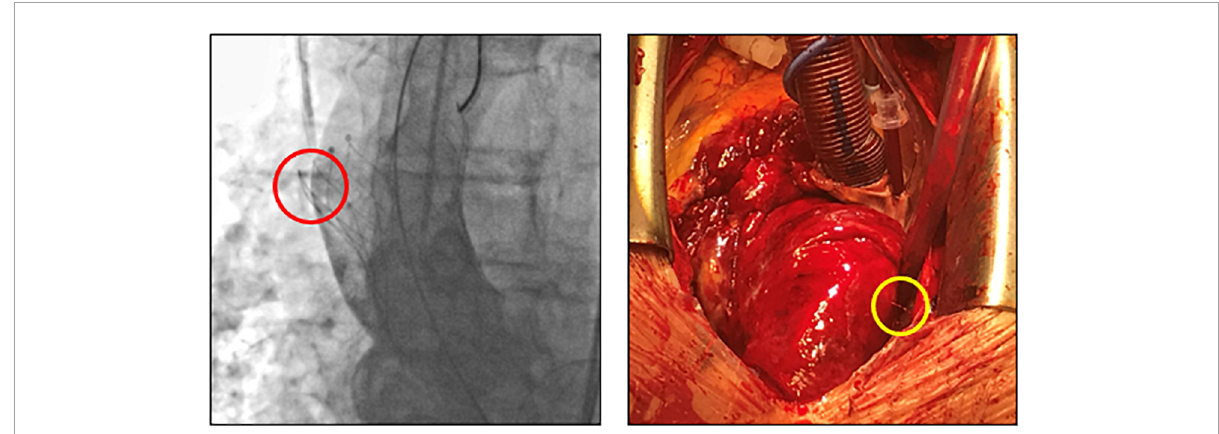
FIGURE6 Fluoroscopic images and intraoperative situs after perforation of the ascending aorta by an embolized self-expanding valve. Fluoroscopy (left) and intraoperative situs (right) of a patient with hemorrhagic shock due to perforation (circles) of the ascending aorta. After embolization, the self-expanding valve (25 mm Portico) was deliberately pulled further into the ascending aorta to avoid coronary